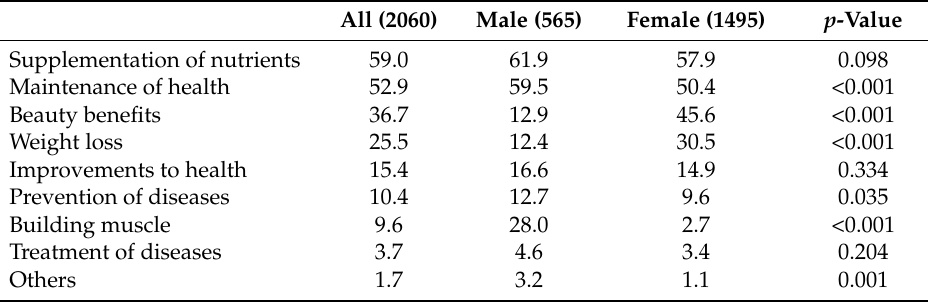
Table 5. What is the purpose of dietary supplement use? (%).